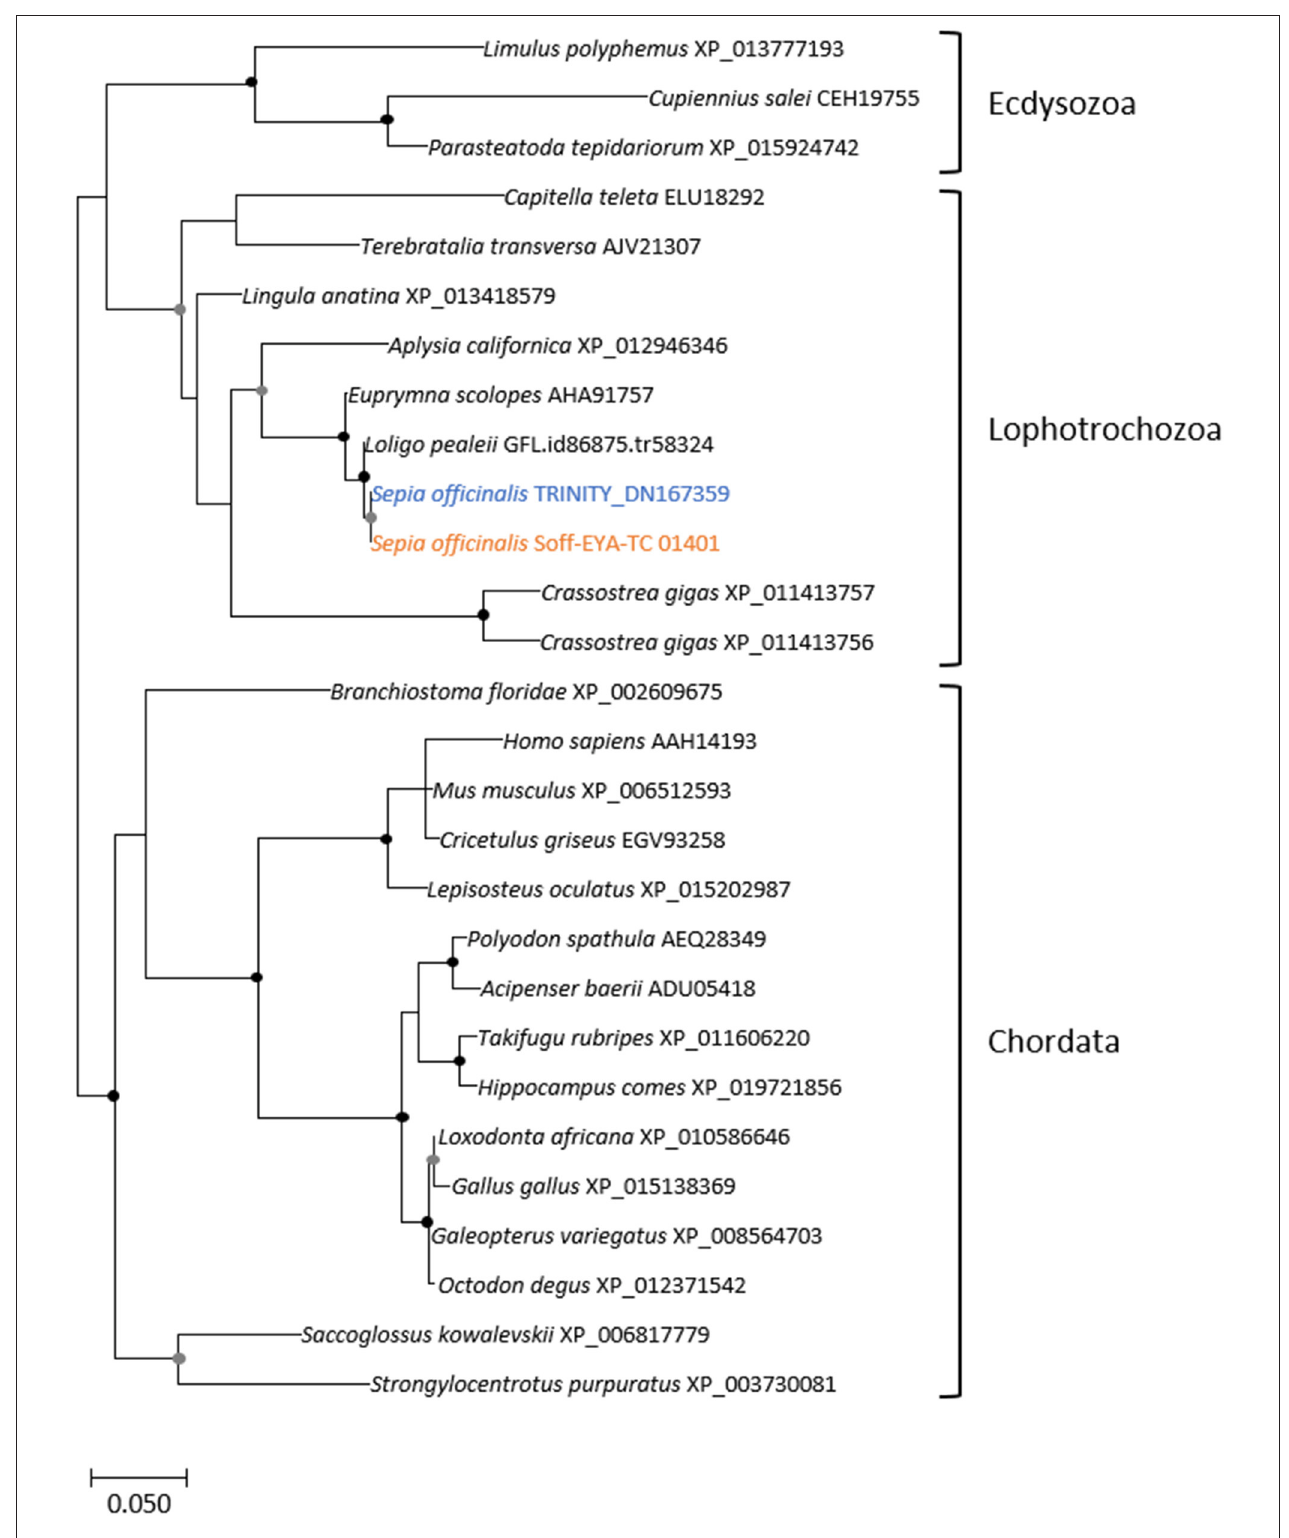
FIGURE 3 | Diversity of eyes absent (EYA) homolog. Maximum-likelihood tree based on 287 aligned amino-acids. The specific S. officinalis EST is shown in orange, and the S. officinalis contig/gene is in blue. Bootstrap support values are shown in the circles at the nodes (Black, 100–80%; gray, 80–50%).